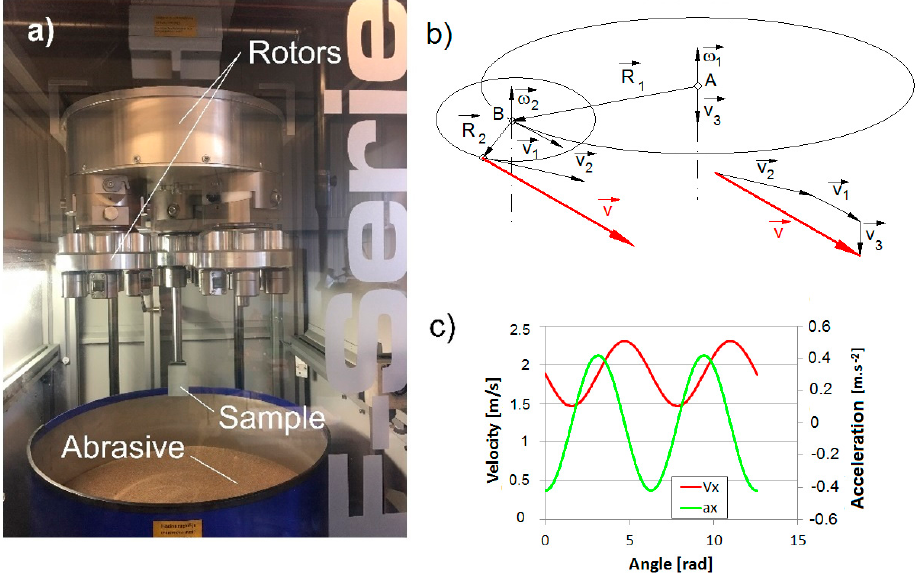
Figure 18. Drag tumbling technology. ( a ) the machine, ( b , c ) an analysis of the speeds and angular accelerations of the sample.